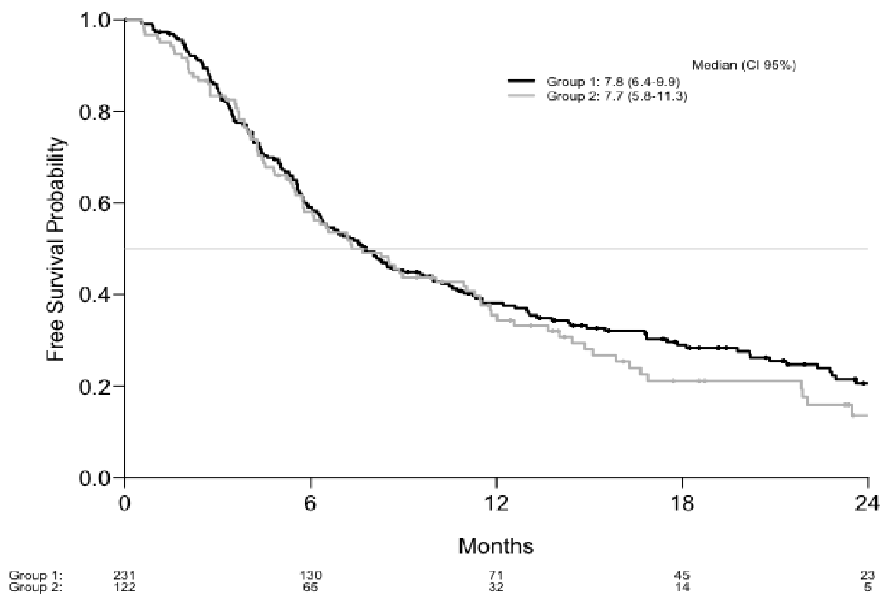
Figure 1. Progression free survival.